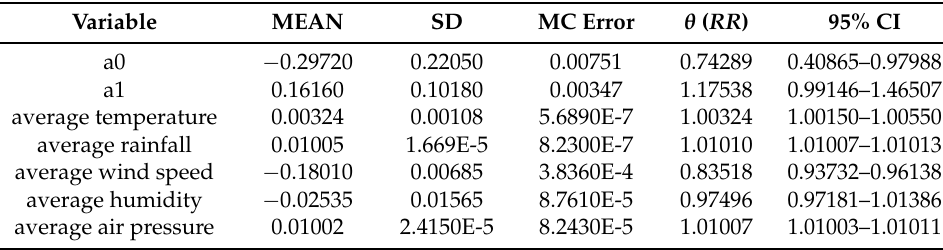
Table 2. Influential climate factors of prevalence for